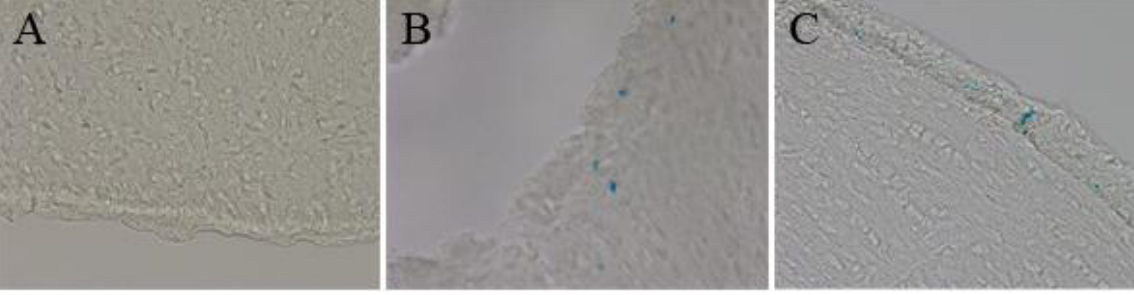
Table 1. Results of the graded comparison between the density of iron-labeling between the chi-MNP and lip-MNP group. The labeling was related to that of non-injected organs in which the endogenous iron-labeling was scored as the 0-value. Organ chi-MNP Lip-MNP Liver +++ + Spleen +++ 0 Lungs + 0 Kidneys 0 + Brain +